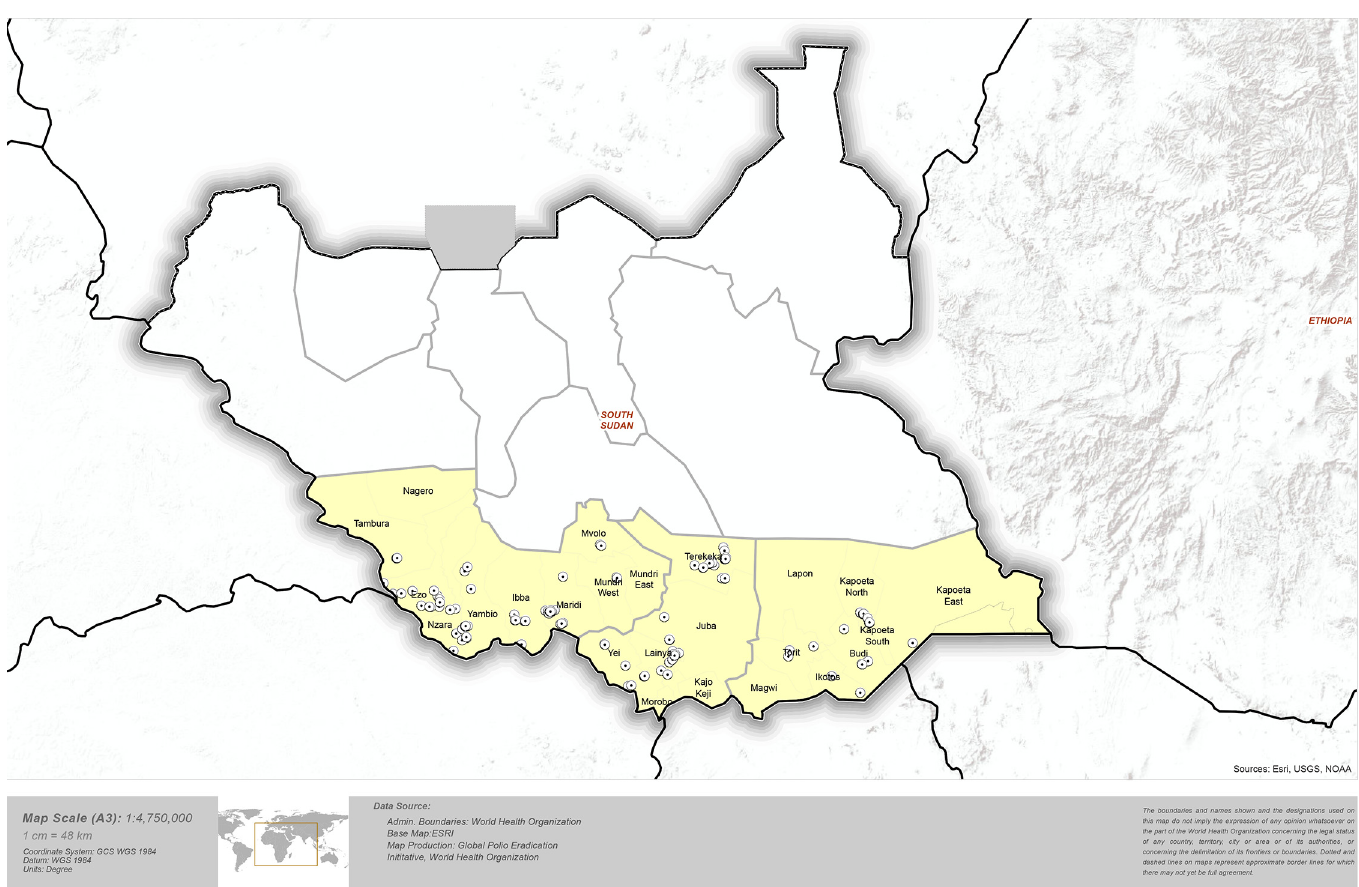
Fig 1. Map of South Sudan with dots representing households mapped during supervision activities * . * 49.0% of households had GPS co-ordinates recorded.